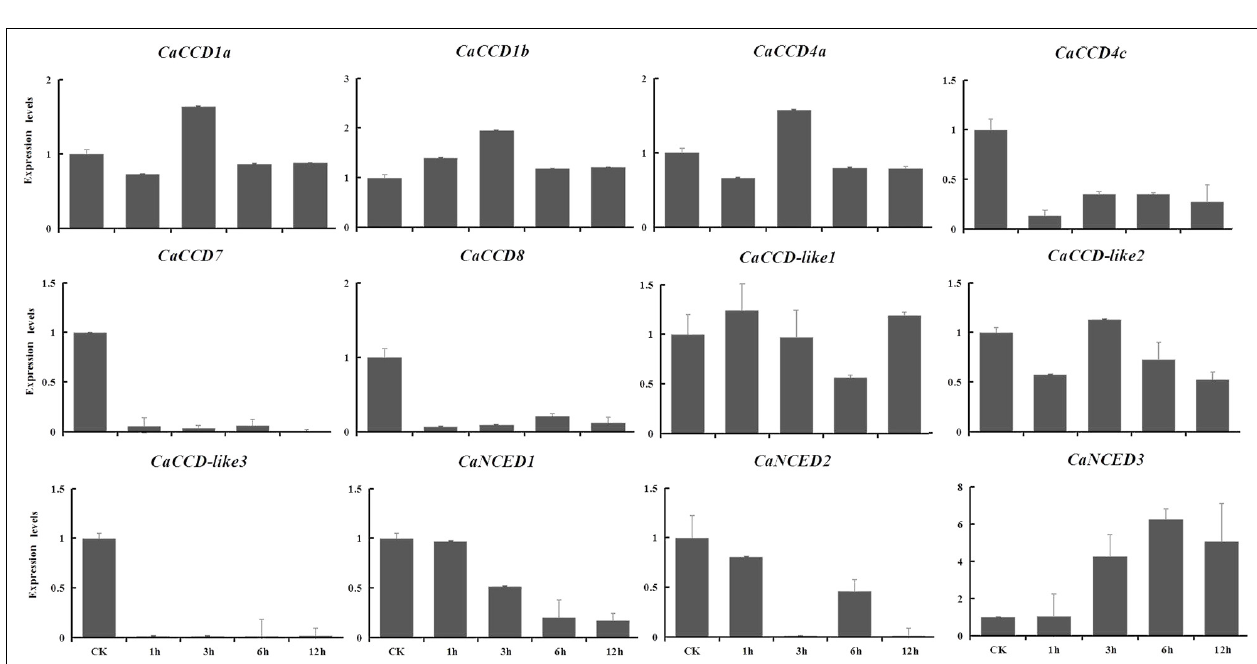
FIGURE 8 | Expression patterns of CaCCO genes in response to cold stress at different time points.